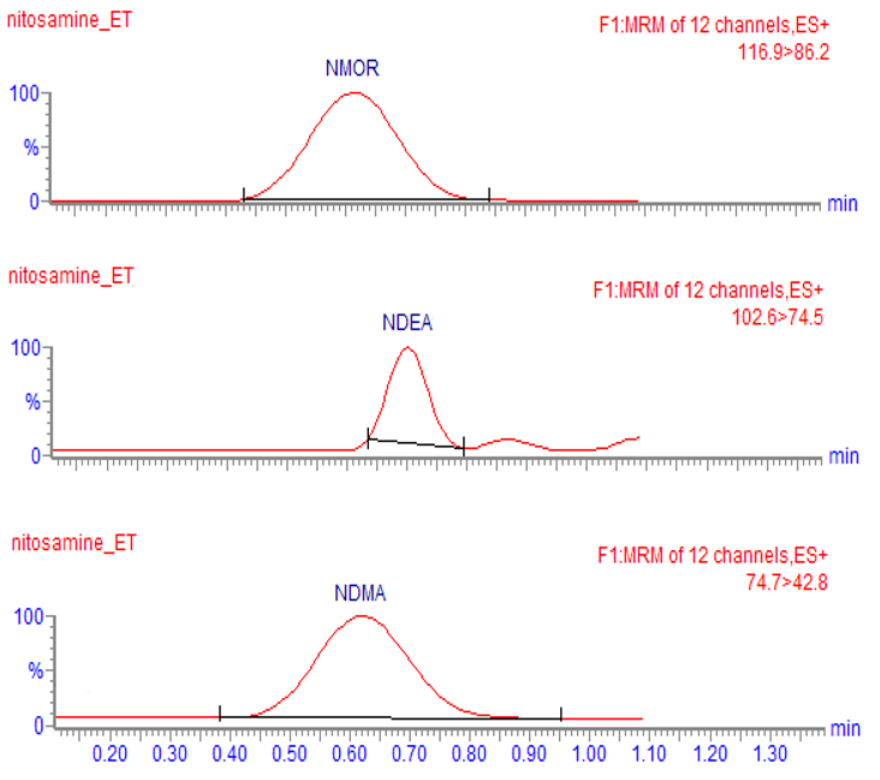
Figure 3. UHPLC-(ESI + )-MS/MS chromatograms of standard solutions at 5 µg L -1 (only quantification transition is shown for each N-nitrosamine), retention time (min), and peak area (arbitrary units).